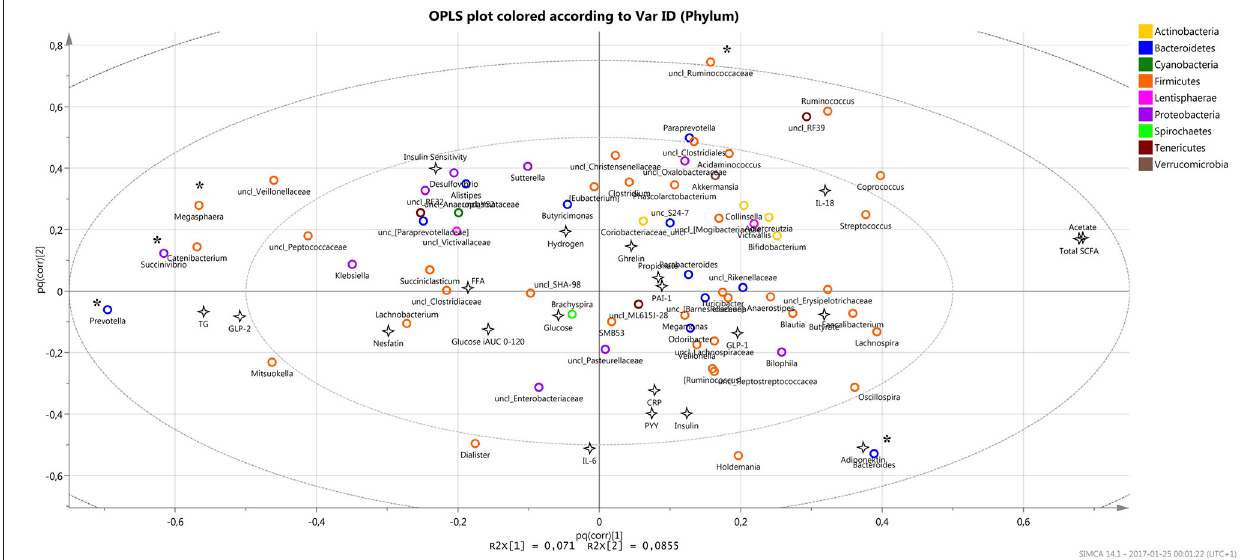
FIGURE 3 | The OPLS plot displays the relation between all X and Y variables in the study (max 74 XY par for each investigated parameter) where the most significant bacteria as X-variables are situated away from the center on the positive or negative side of the plot, with the most significant variables that are found on the periphery (marked *). X and Y variables opposite to each other are negatively correlated while positively correlated variables situated near each